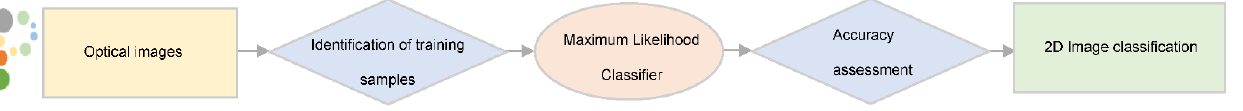
Figure 5. Methodological workflow for image classification.